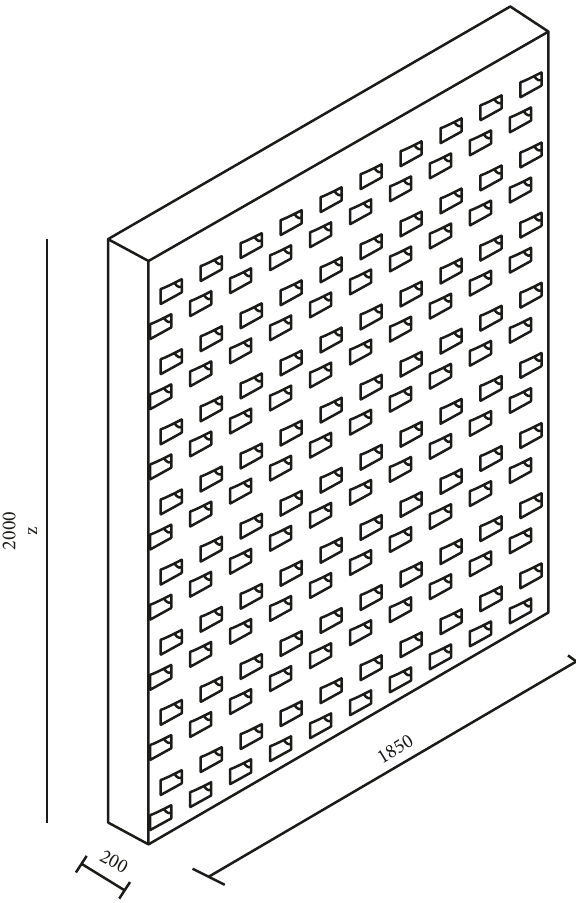
Figure 3: Isometric view of the dentated seawall (adapted from